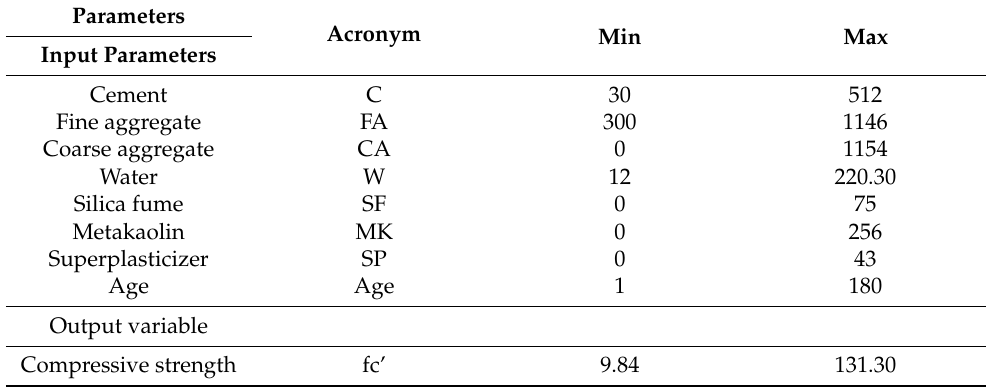
Table 1. Metakaolin concrete compressive strength model input and output variable ranges.